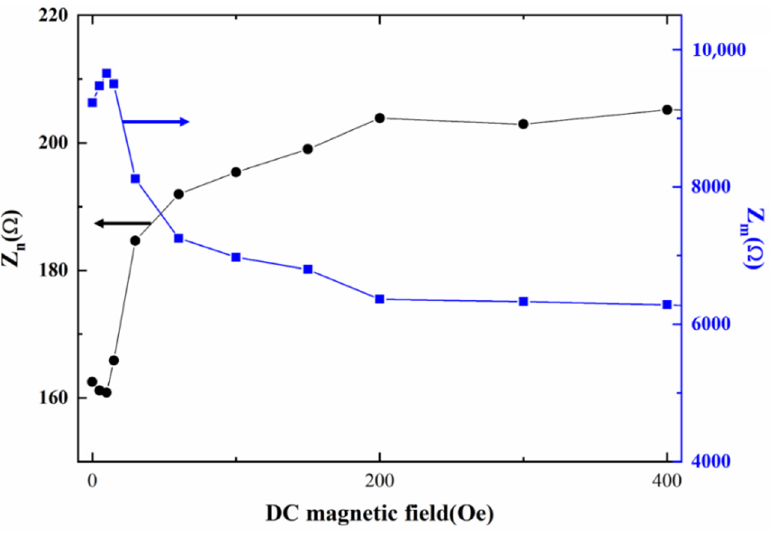
Figure 2. The maximum impedance Z m and minimum impedance Z n as a function of DC magnetic field. The maximum RSDs of maximum impedance and minimum impedance with multiple measurements are 0.24% and 0.25%, respectively.